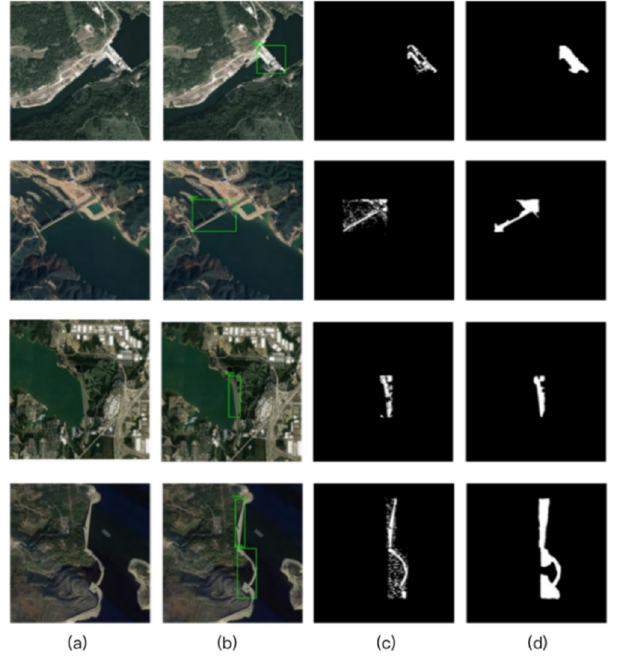
Figure 19. Comparison of dam segmentation without and with the SLIC algorithm. ( a ) Original images; ( b ) dam detection results; ( c ) dam segmentation results without the SLIC algorithm; ( d ) dam segmentation results with the SLIC algorithm.